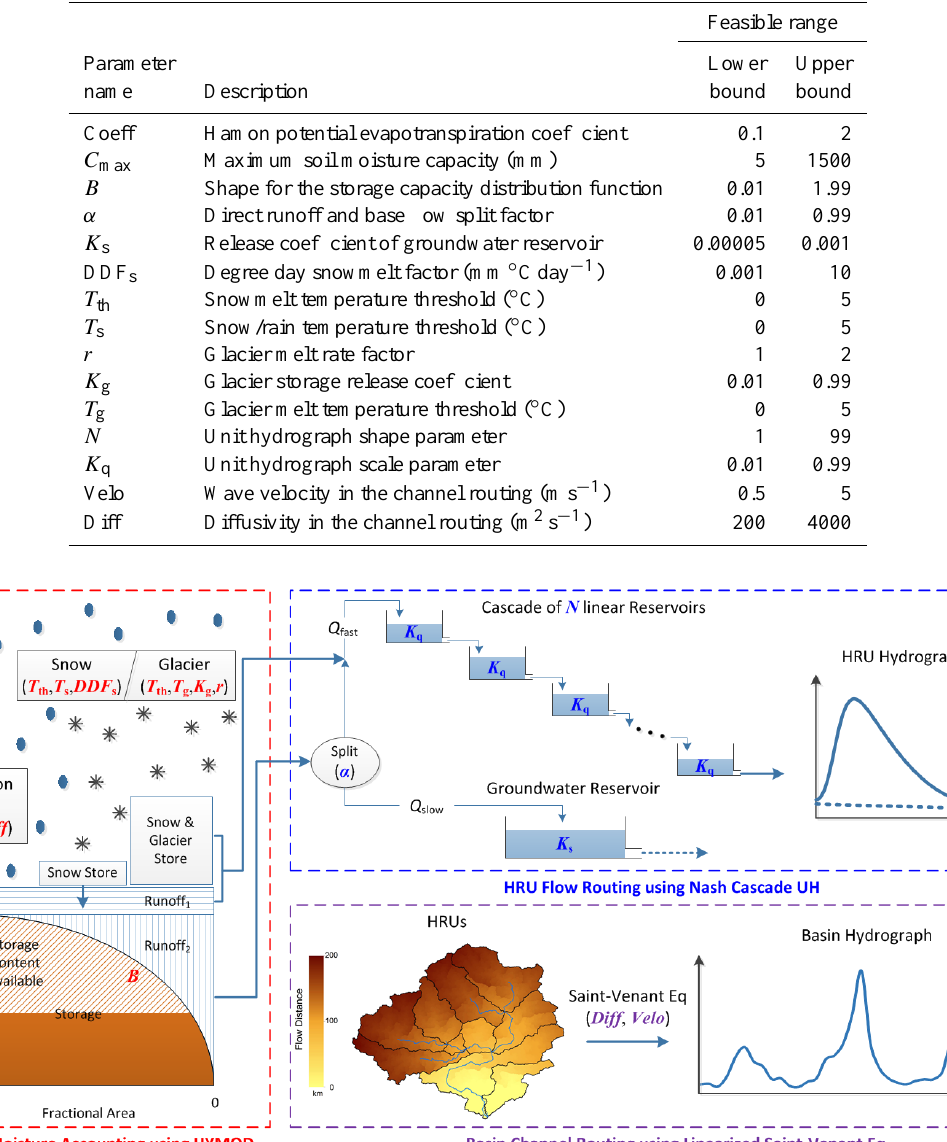
Table 2. HYMOD_DS parameters.